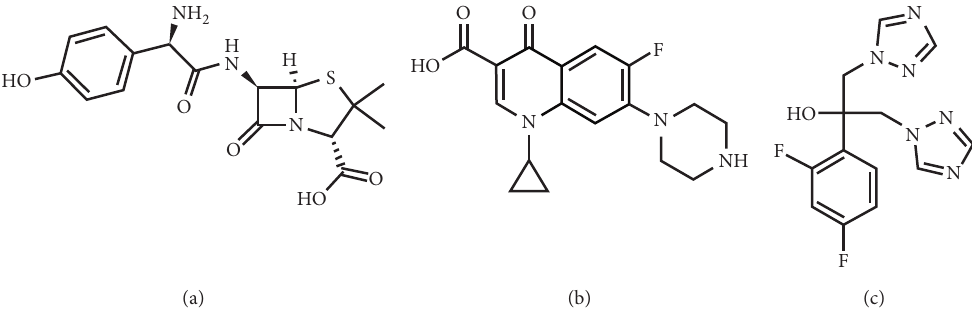
Figure 1: Chemical structures of some standard antibiotics [11]: (a) amoxicillin; (b) ciprofloxacin; (c)